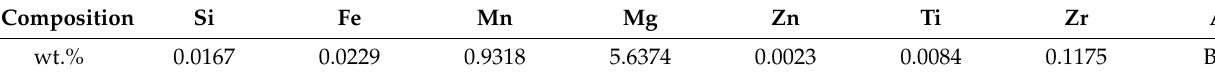
Table 1. Chemical composition of 1561 aluminum alloy plates (by wt.%).